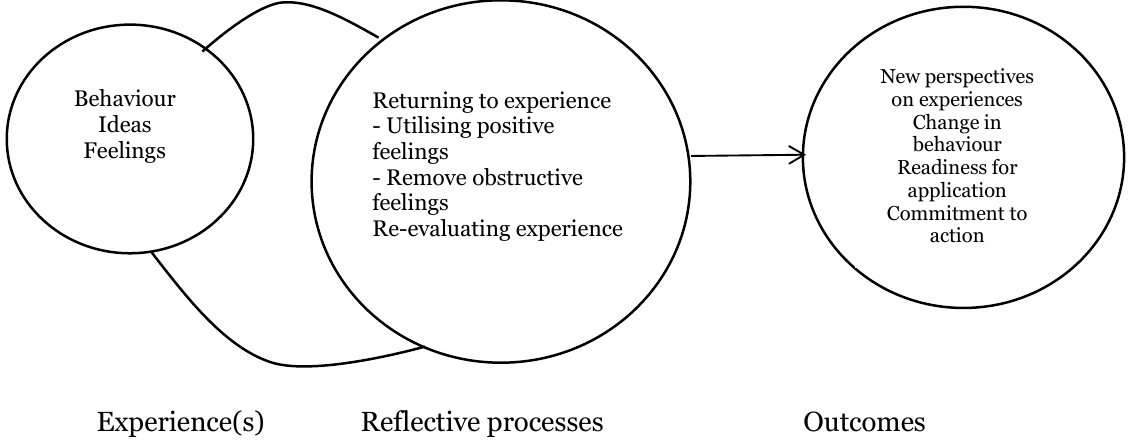
Figure 1 . The reflection process in context (adaption of Boud, Keogh & Walker’s 1985